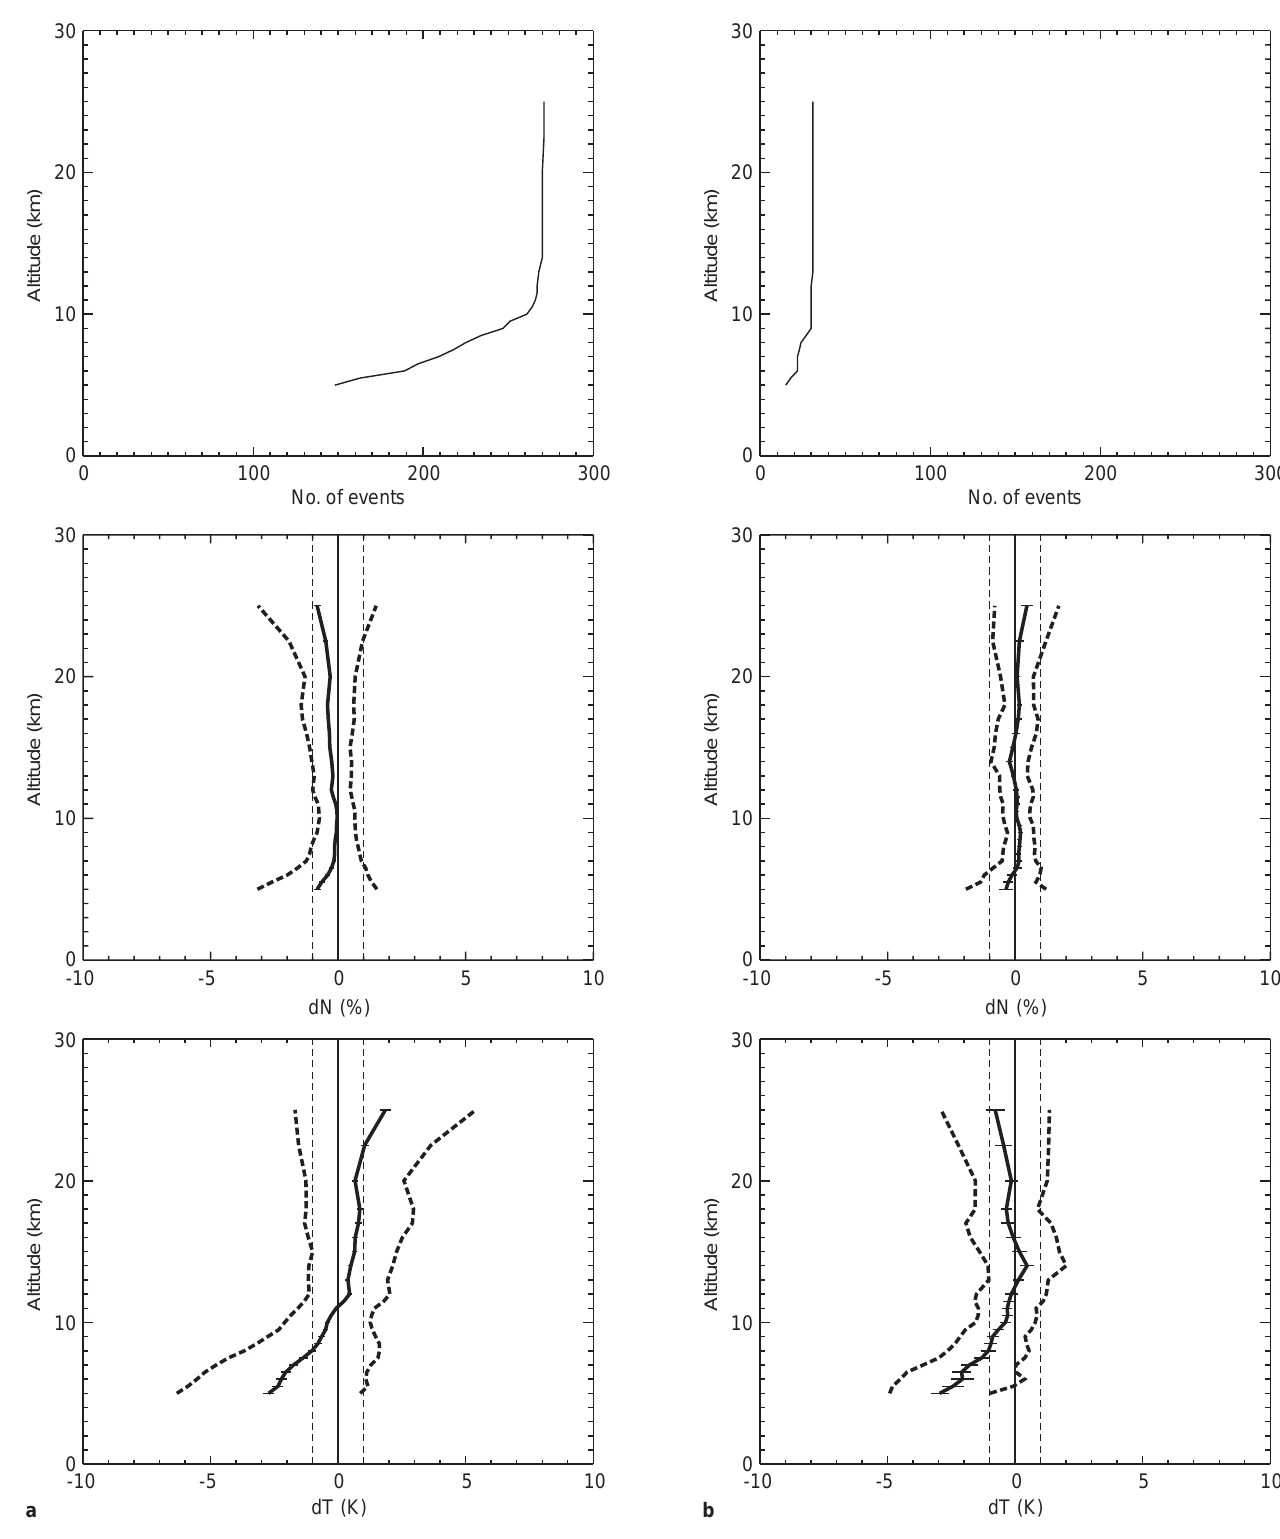
Fig. 10a, b. Results of statistical validation of GPS/MET data with ECMWF data. The top panels show the number of occultation events used (decreasing below 10 km, since the lower boundary of individual events excludes tropospheric data of notably degraded quality). Refractivity di(cid:128)erences (d N ) are depicted in the middle panels , temperature di(cid:128)erences (d T ) in the bottom panels . The solid lines